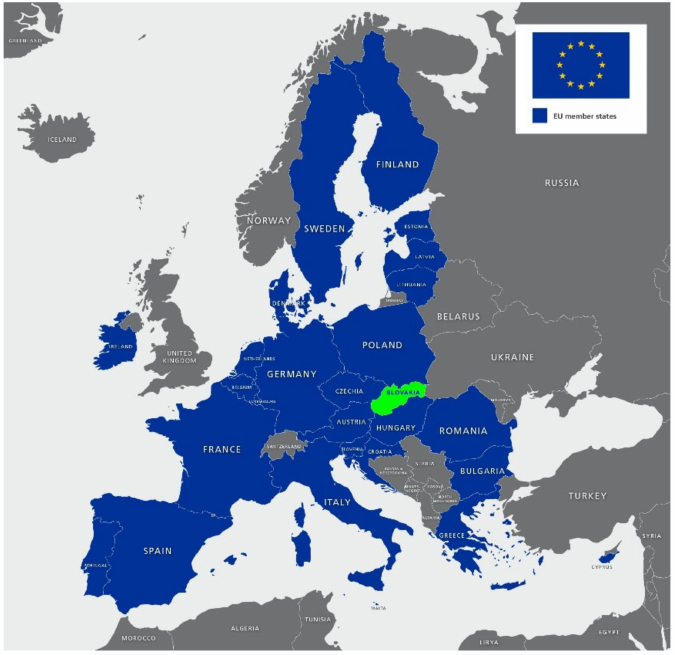
Figure 1. Location of the Slovakia in the EU [Base https://maproom.net/, accessed on 22 April